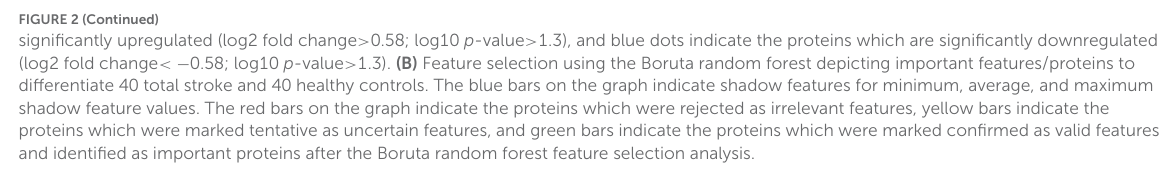
(Figure 8A). Using the Boruta random forest method, 21 more proteins were further identified as confirmed/tentative features (Figure 8B; Supplementary Table 4). Ten proteins (UniProt